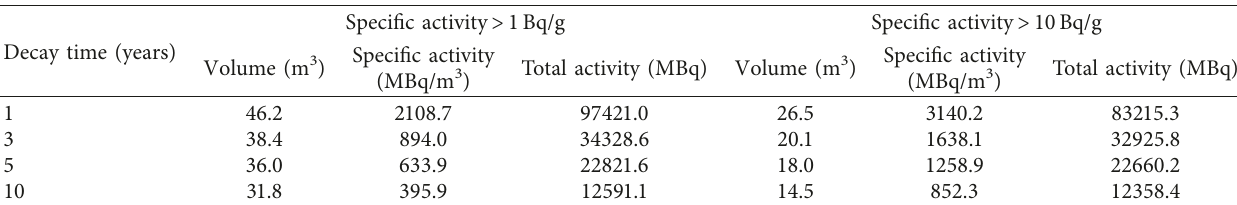
Table 5: Activity of concrete in the reactor concrete structure.